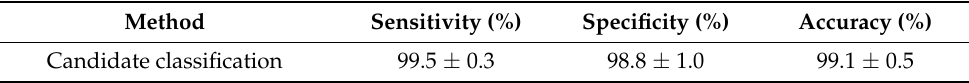
Figure 6. Segmentation results with and without the candidate classification step. Panels are as fol- lows: ( A ) manual annotation, ( B ) results before candidate classification, and ( C ) results after candi- date classification. There were some false positives from the candidate segmentation step ( B ), which were effectively ruled out with the candidate classification step ( C ). The red is a microvessel. Table 2. Mean performance metrics of the candidate classification network over five folds, including the Dice coefficient, sensitivity, specificity, and accuracy. The network was trained/validated/tested on manually annotated data. Our CNN model showed remarkable classification results and was very useful to classify each candidate as either microvessel or non-microvessel. All metrics are re- ported as the mean and standard deviation over the five folds.